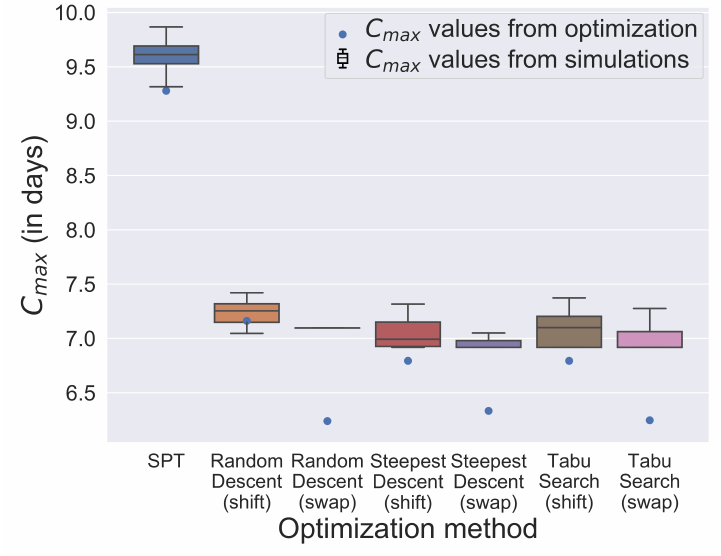
Figure 20. Comparison of simulation results per optimization method for calendar week 12 with quantile